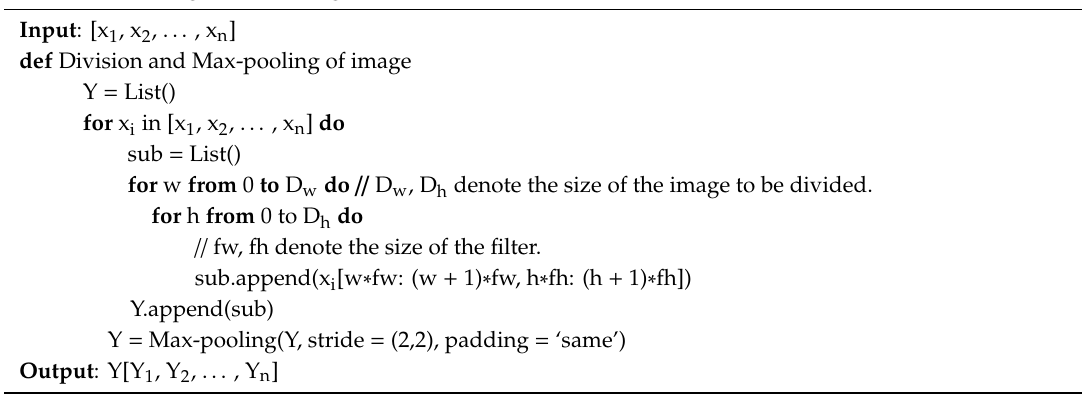
Algorithm 1 Image Division